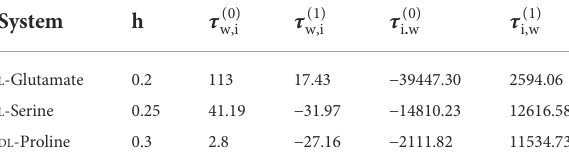
TABLE 5 Model parameters for binary electrolyte solutions in the model.